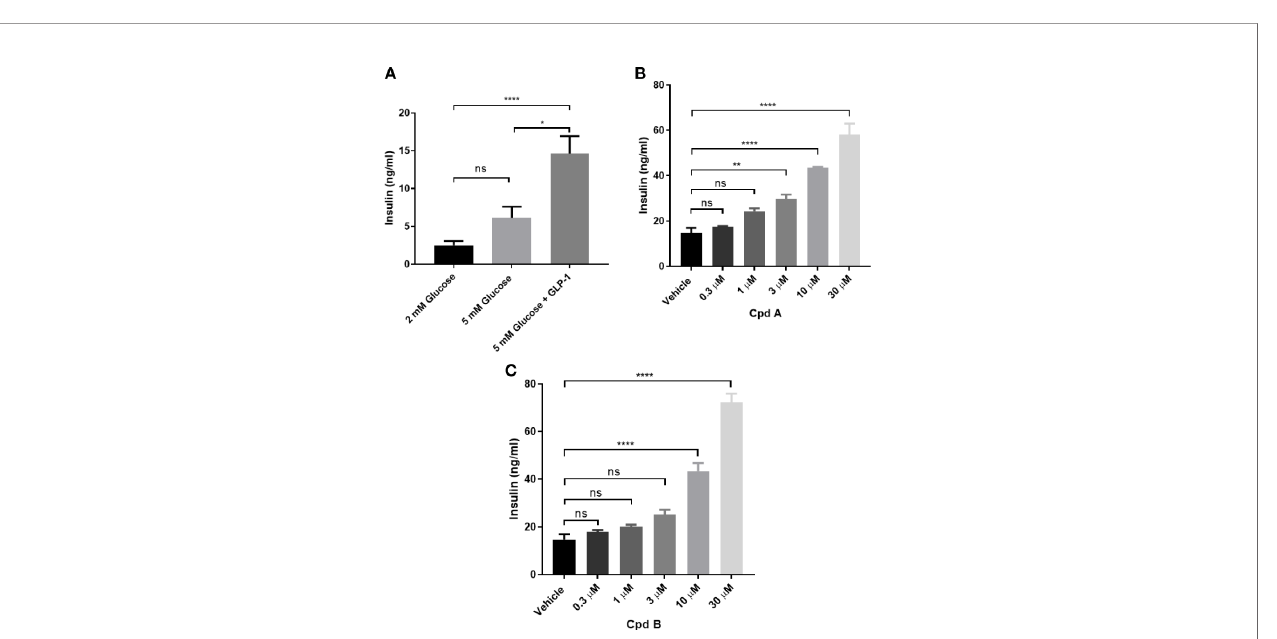
FIGURE 2 | GLP-1 mediated insulin secretion in INS-1 832/13 cells . (A) GLP-1 mediated insulin secretion; (B) Effect of Cpd A on 10 nM GLP-1 mediated insulin secretion at 5 mM glucose; (C) Effect of Cpd B on 10 nM GLP-1 mediated insulin secretion at 5 mM glucose. Values represent the mean of fi ve replicates ± SEM. Statistical comparison for more than 2 datasets are assessed by one-way ANOVA with Dunnett ’ s multiple comparisons test. *P = 0.01-0.1, **P = 0.001-0.01, ****P < 0.0001; ns, not signi fi cant. Unpaired t-test was performed for 2 datasets.